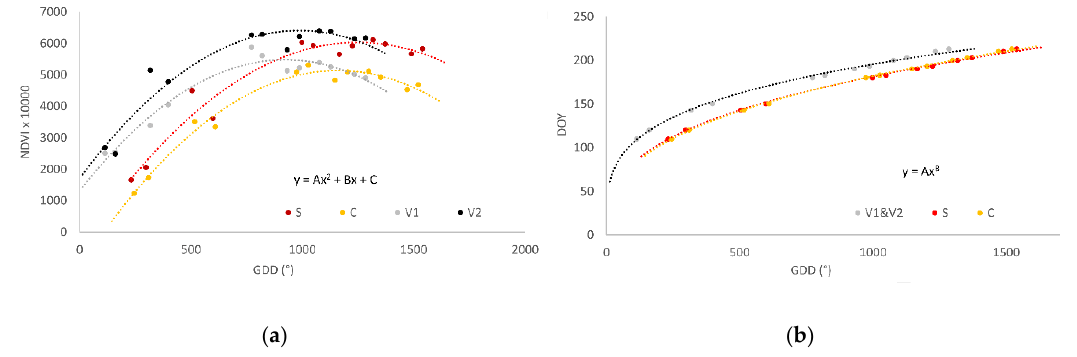
Figure 9. ( a ) NDVI versus growing degree days (GDD). ( b ) DOY versus GDD. In all the vineyards the two parameters were highly correlated and showed the same type of relationship (2nd order polynomial). Table 4. Coefficients of models relating GDD to NDVI (1) and GDD to DOY (2) as estimated by ordinary least squares. A parabolic model proved to fit the relationship well (1); differently, a power model proved to fit the relationship well (2).